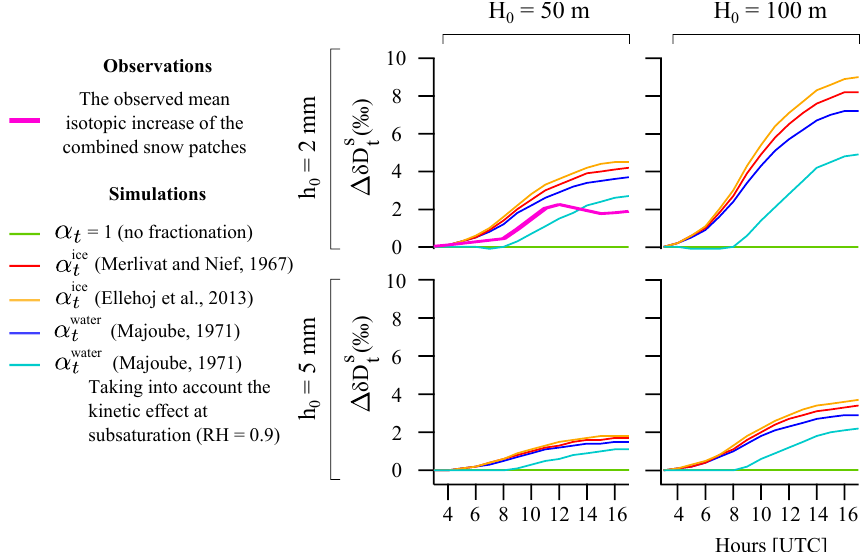
Figure 9. Simulated (box model) deuterium anomalies of the snow surface during the warming phase, with h 0 , H 0 and the fractionation coefficients as varying inputs parameters. The initial isotopic composition of the snow surface has been taken as the average of the 100 daily =− 320‰. snow samples collected at Kohnen over the period of measurements, δ D s 0 (Fig. 9). Simulations with different values of H 0 , h 0 and α